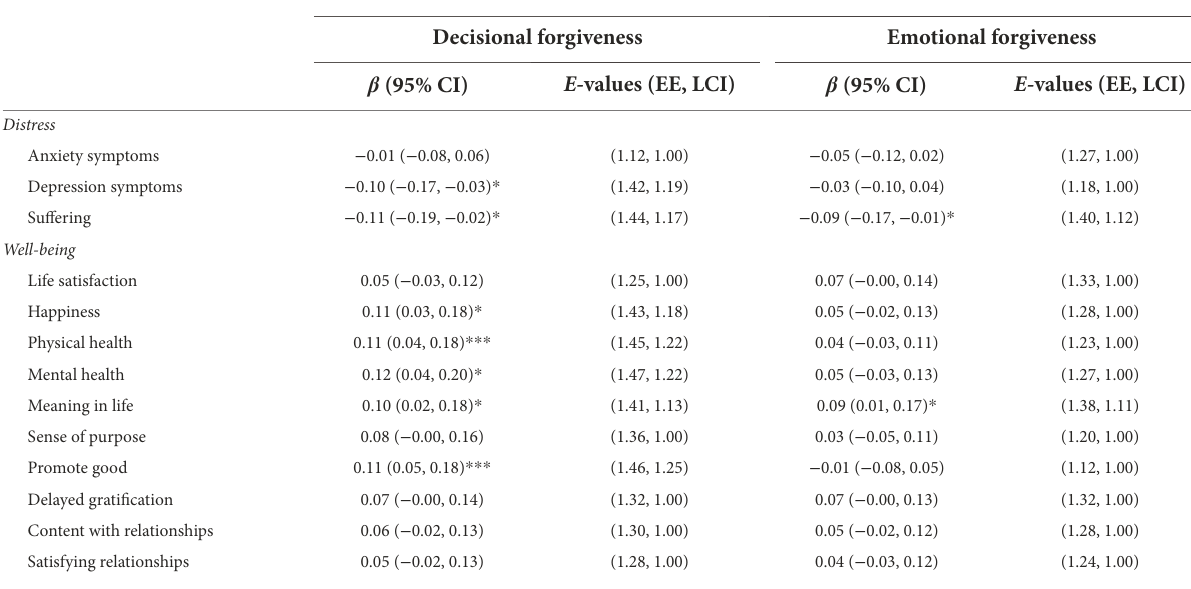
TABLE 2 Associations of candidate antecedent ( T 2 ) with decisional and emotional forgiveness assessed 1 month later ( T 3 ). Candidate antecedent Outcome Decisional forgiveness